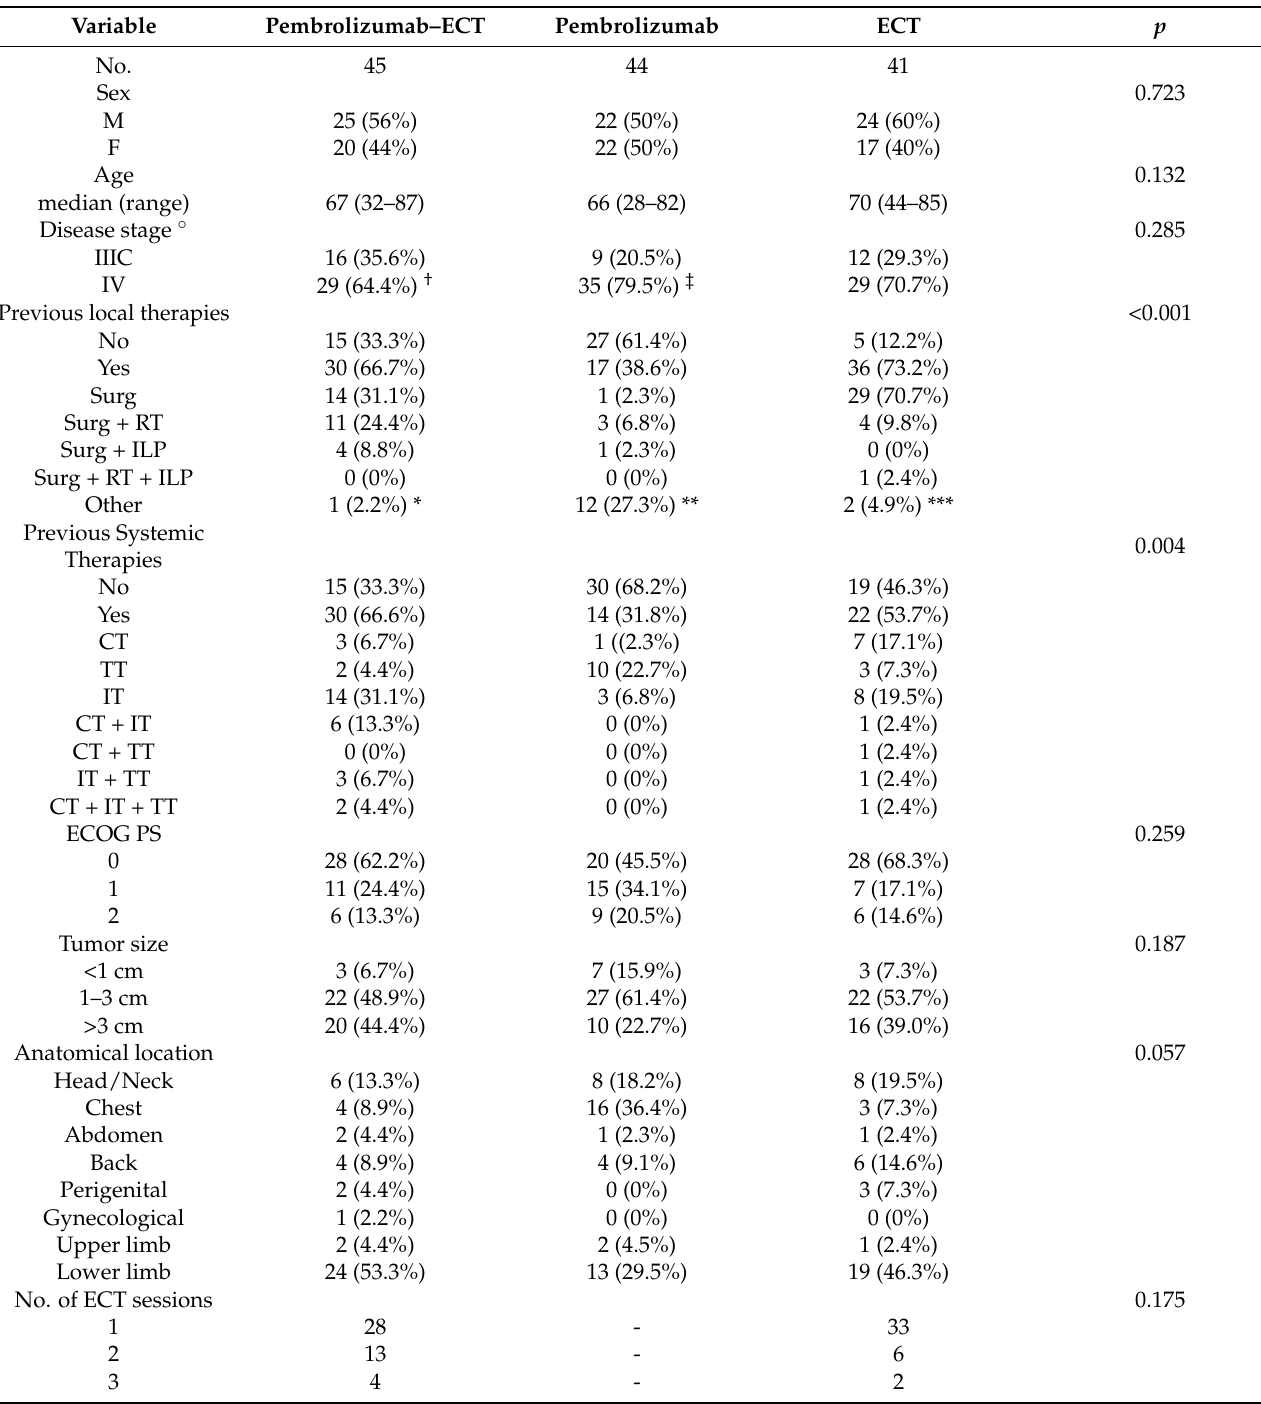
Table 1. Patient